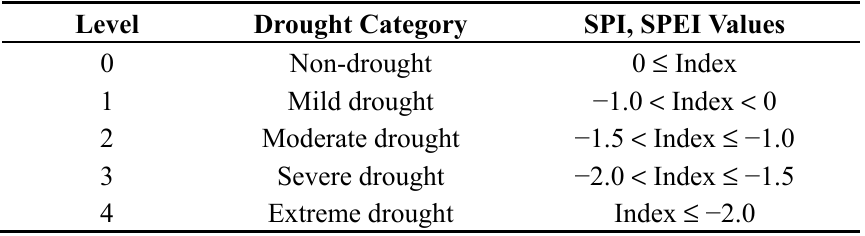
Table 1. Drought classification based on the SPI and